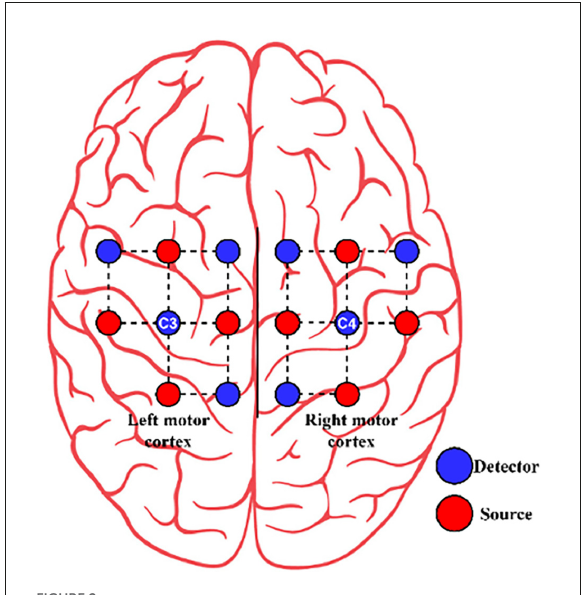
FIGURE2 The arrangement of source (red circle) and detector (blue circle) for Dataset A.